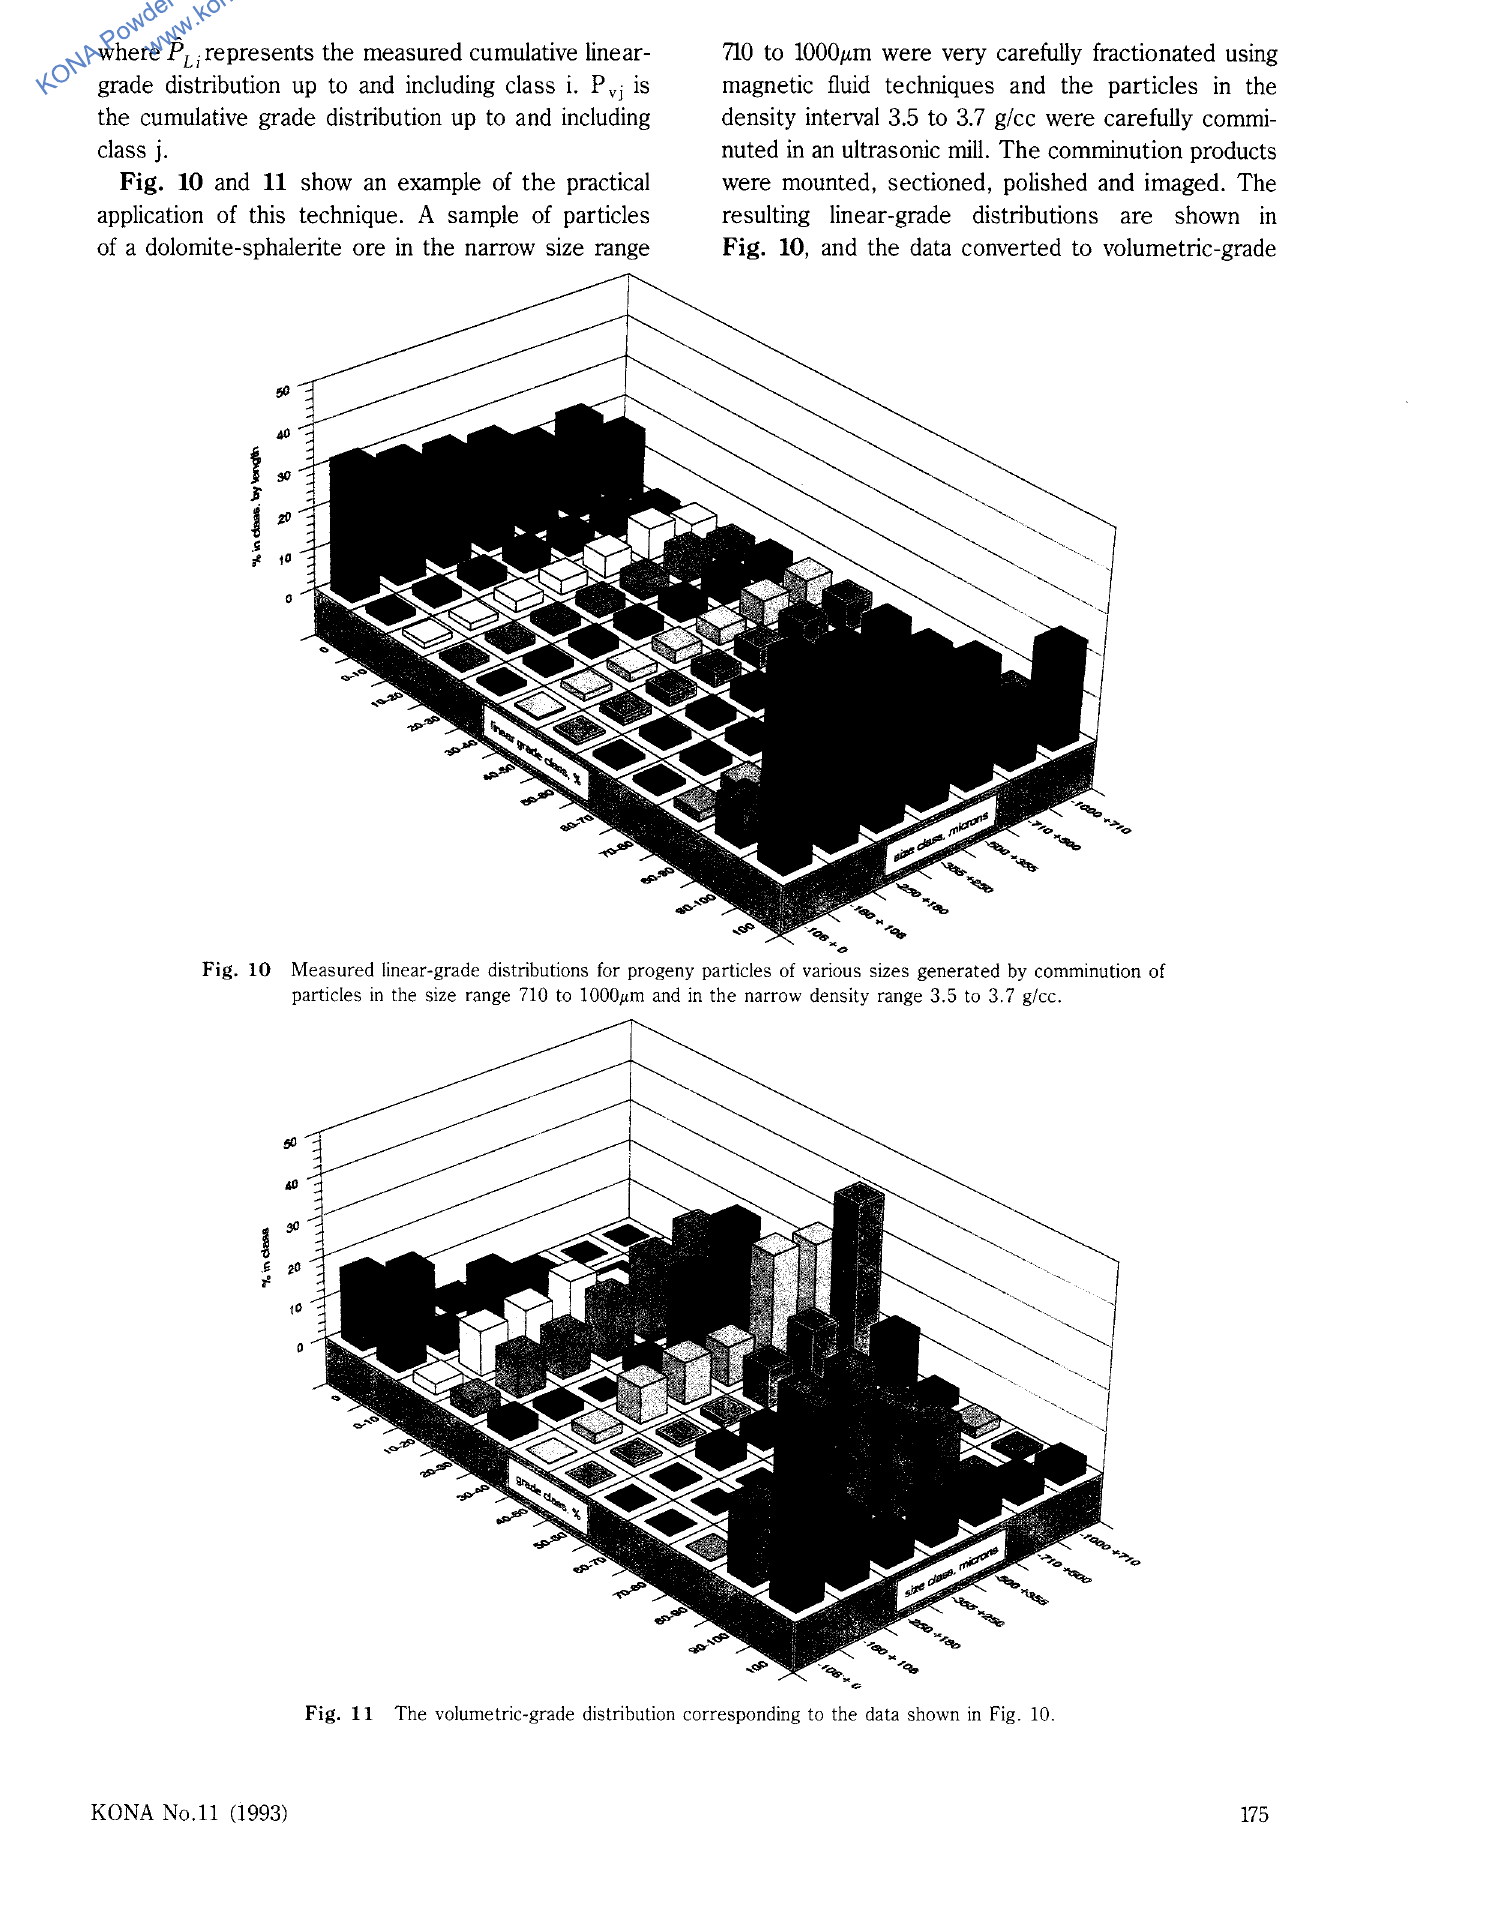
Fig. 11 The volumetric-grade distribution corresponding to the data shown in Fig.